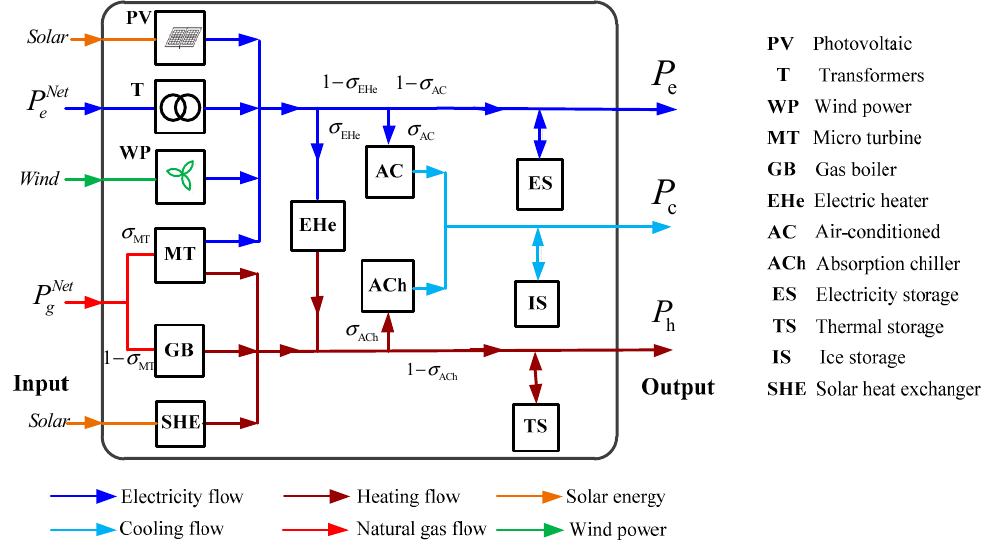
Figure 3. Proposed energy hub model.